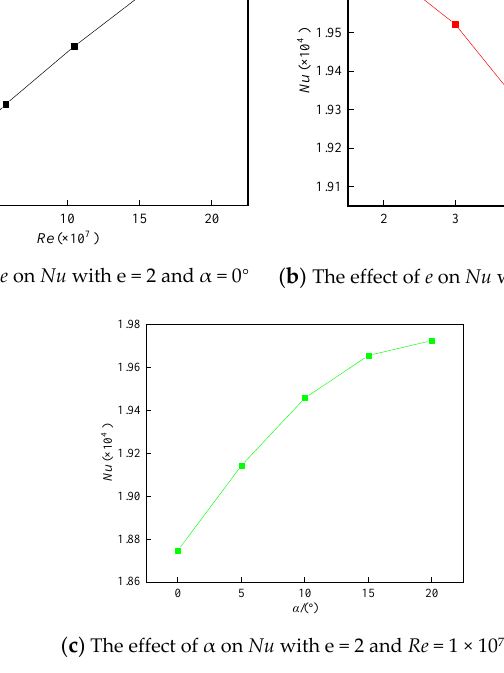
Figure 4. The relation of Nu vs. Re , e , and α.